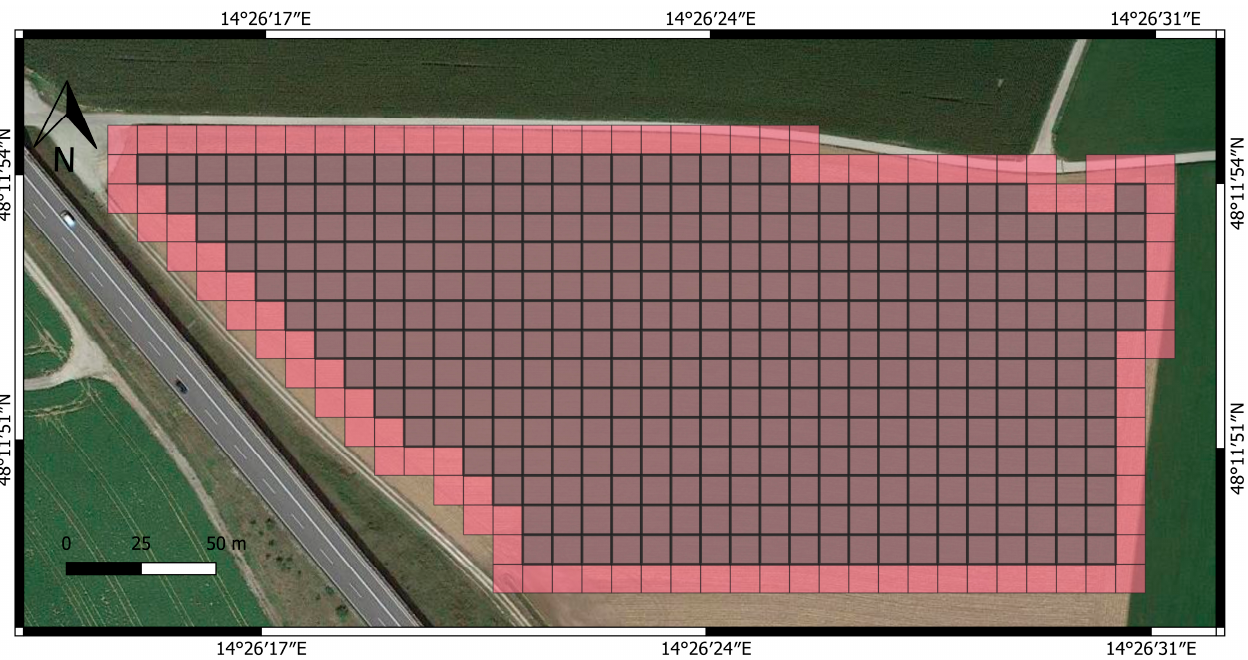
Figure 6. Sentinel-2 pixel grid (transparent) placed over yield polygons (magenta).